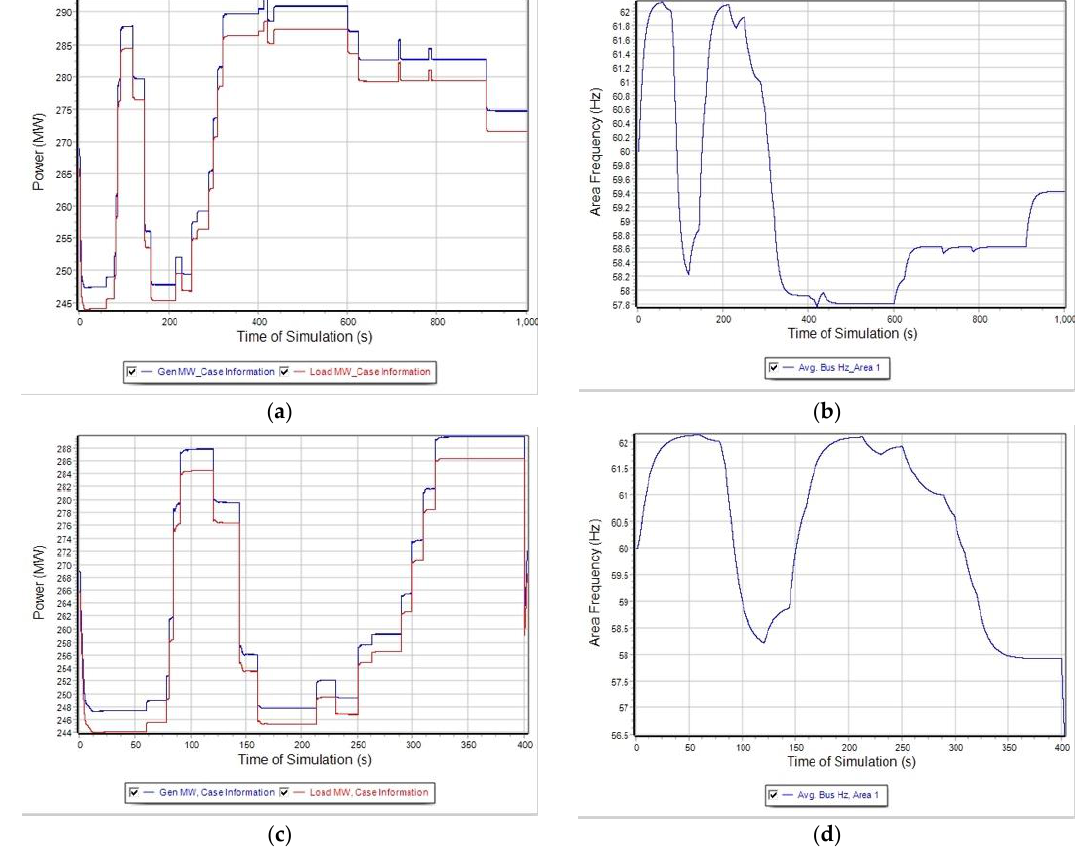
Figure 3. Simulation results. ( a ) Generation and load: no attack; ( b ) area frequency: no attack; ( c ) generation and load: attack; and ( d ) area frequency: attack. ( Gen in Figure refers to Power Generation in MegaWatts).